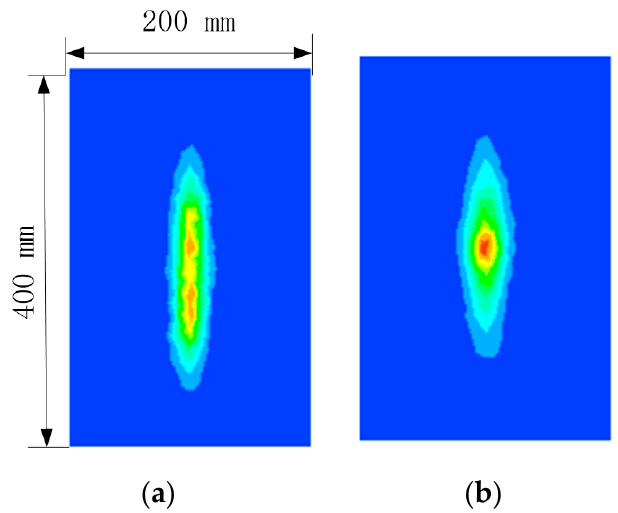
Figure 16. Coating film thickness contours: ( a ) double-nozzle air spray gun; ( b ) single-nozzle air spray gun.